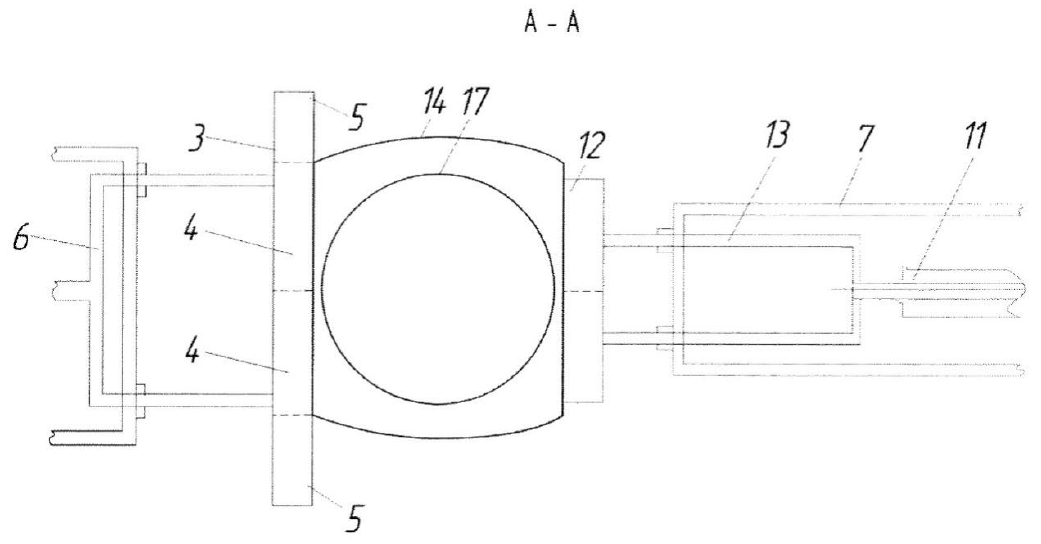
Figure 16. Scheme of the FC gripping and opening.